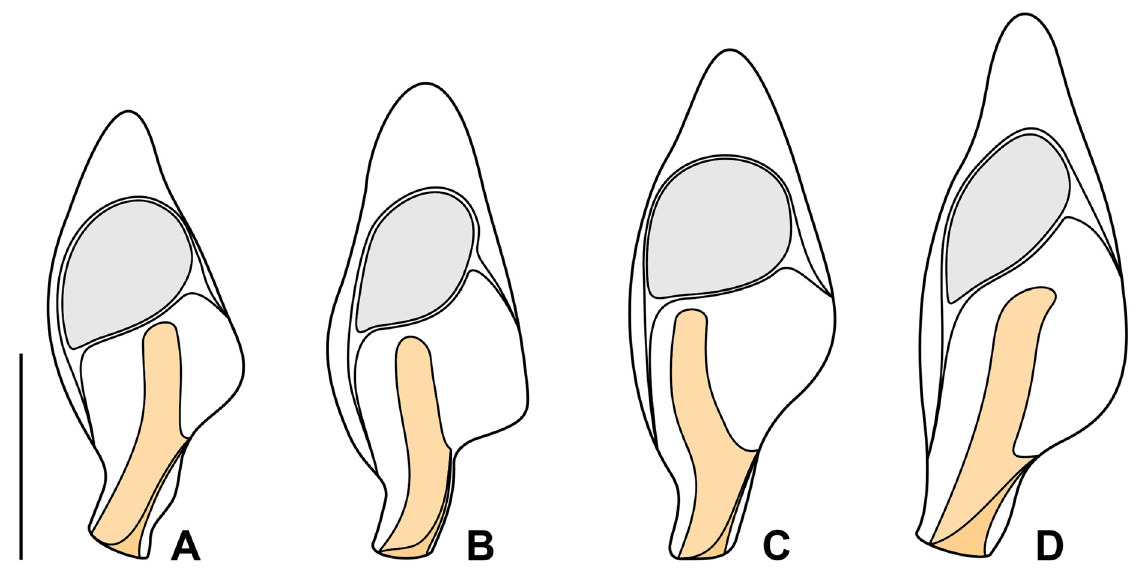
Fig. 7. Clevelandella panesthiae (Kidder, 1937). Vietnamese specimens isolated from Panesthia angustipennis cognata Bey-Bienko, 1969 after protargol impregnation. A–D . Variability of body shape and size as well as of the nuclear (shaded grey) and oral (shaded yellow) apparatus. Scale bar = 50